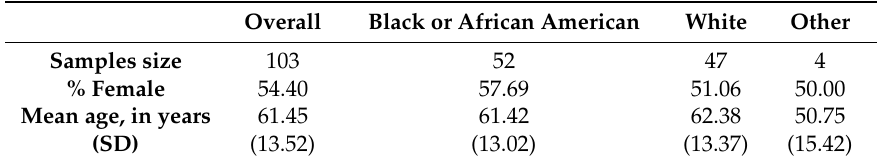
Table 1. Survey respondent demographics. Race/ethnicity, age at survey, and sex were extracted from the MetroHealth System electronic health record for consented patients who provided a biospecimen and completed the survey. Other includes American Indian and Alaska Native, Hispanic or Latino, and